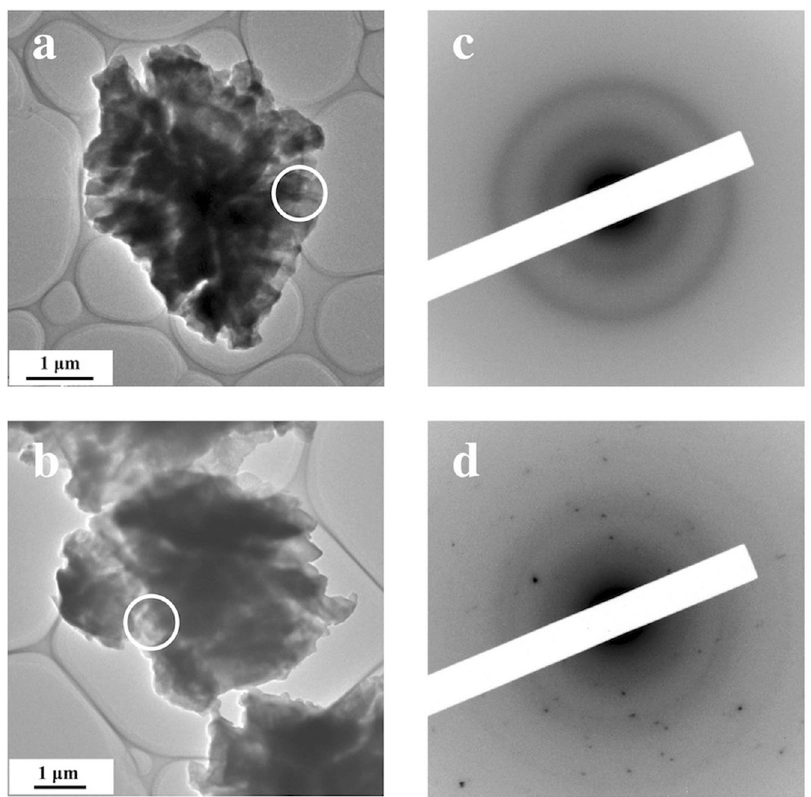
Figure 8. TEM images and selected area electron diffraction patterns of the 75Li 2 S-25P 2 S 5 sulfide glass ceramic. ( a , b ) Bright-field images before annealing and after annealing at 180 °C. ( c , d ) Selected area electron diffraction patterns taken from the bright-field